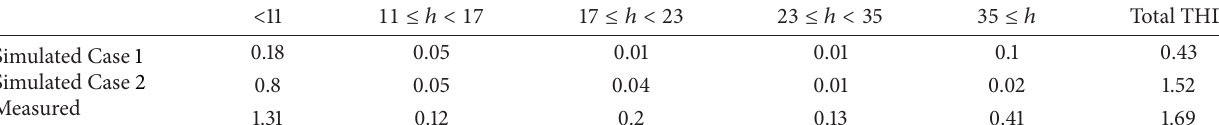
Table 6: Maximum harmonic current distortion in percent of 𝐼 𝐿 for nominal power.